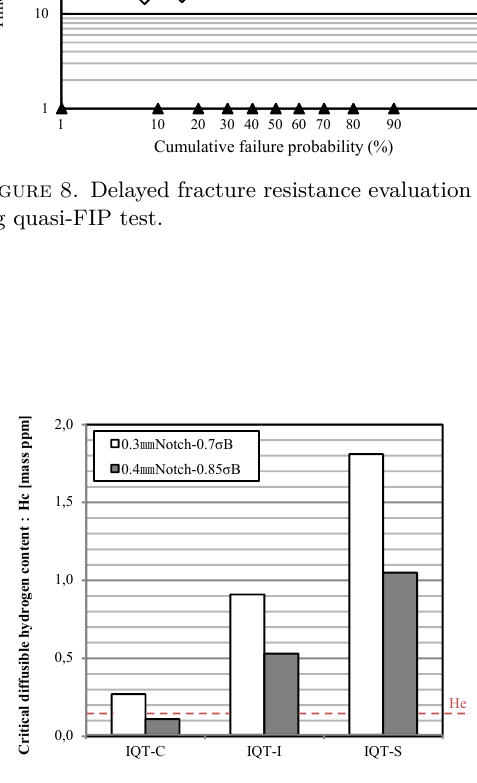
Figure 9. Measurement result of critical di ff usible hydrogen (Hc) without delayed fracture after 100 h.